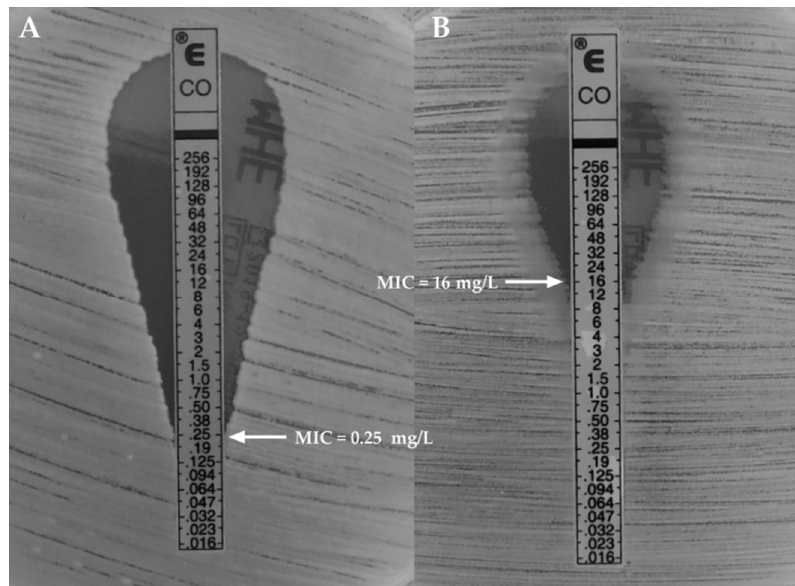
Figure 1. Minimal inhibitory concentration (MIC) of colistin-susceptible (( A )— K. pneumoniae Col-S ) and induced high-level colistin-resistance (( B )— K. pneumoniae Col-R ) K. pneumoniae strains.